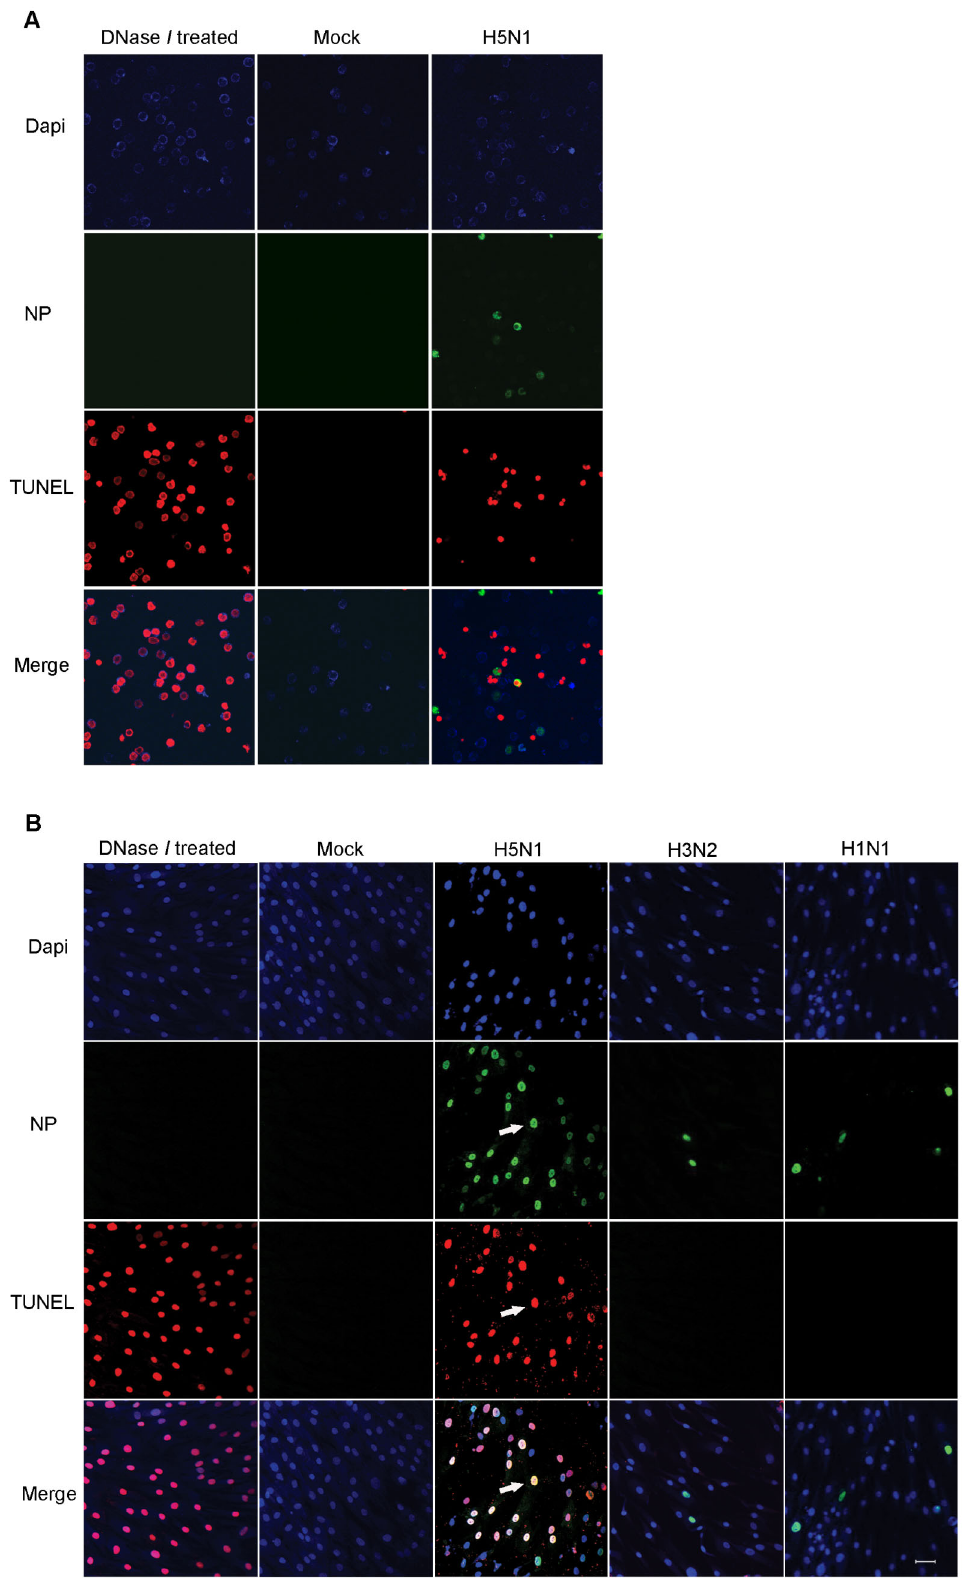
Figure 4. H5N1 infection induced marked CD34 + HSC and MSC apoptosis. ( A ) CD34 + HSCs were infected with H5N1 virus at an MOI of 10, whereas ( B ) MSCs were infected with either avian or human influenza virus at the same MOI as CD34 + HSCs. Parallel samples were treated with DnaseI which breaks double stranded DNA as a positive control. After 18 h, cells were fixed, permeabilized and multiple stained using Terminal